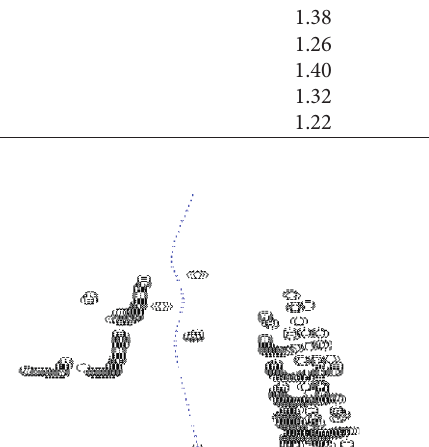
Figure 25: The planning result of RRT ∗ . Table 5: The main evaluation indicators of two contrastive path planning